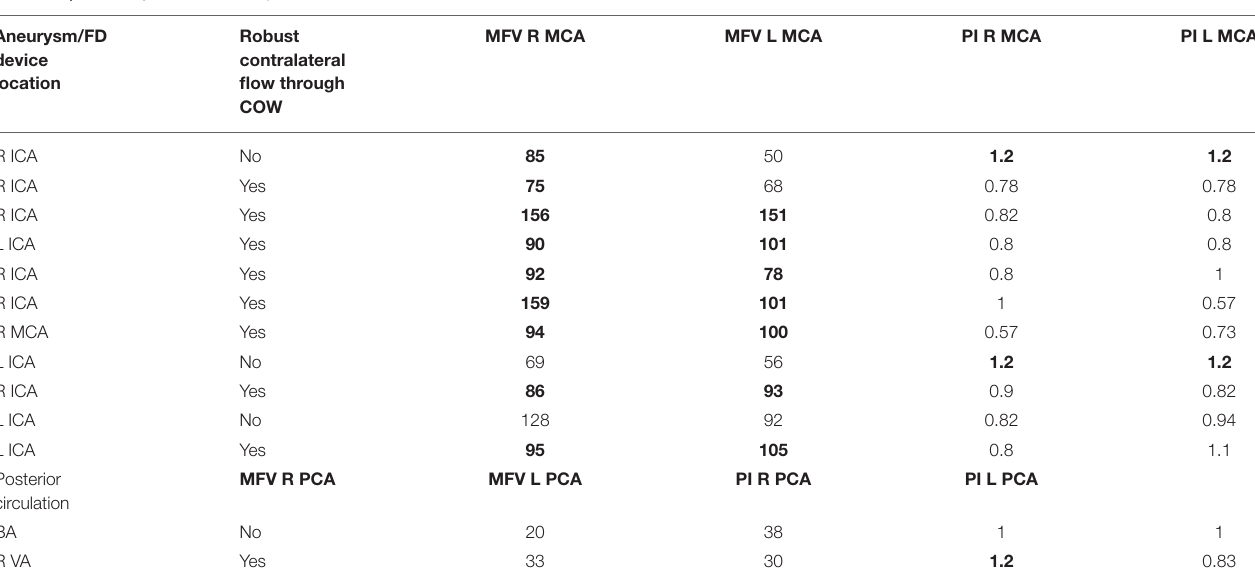
TABLE 2 | Summary of TCD results post FD treatment. Aneurysm/FD device